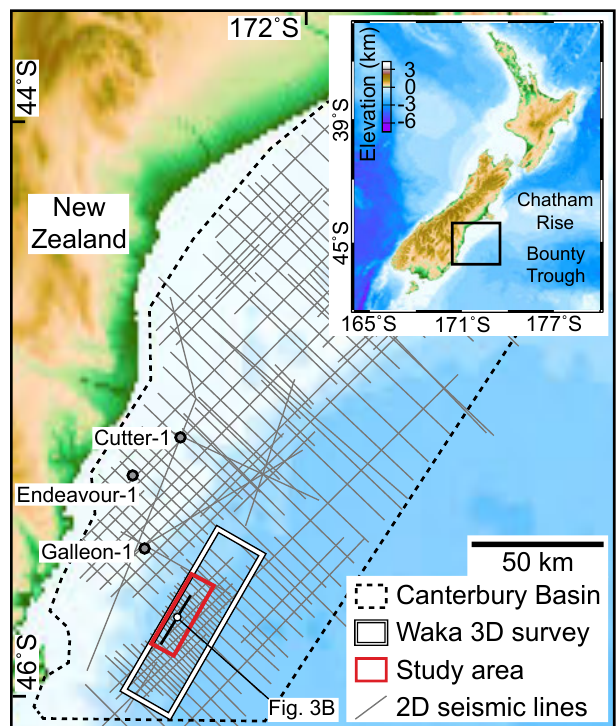
Figure 1: Location map of the study area and available seismic reflection and borehole data